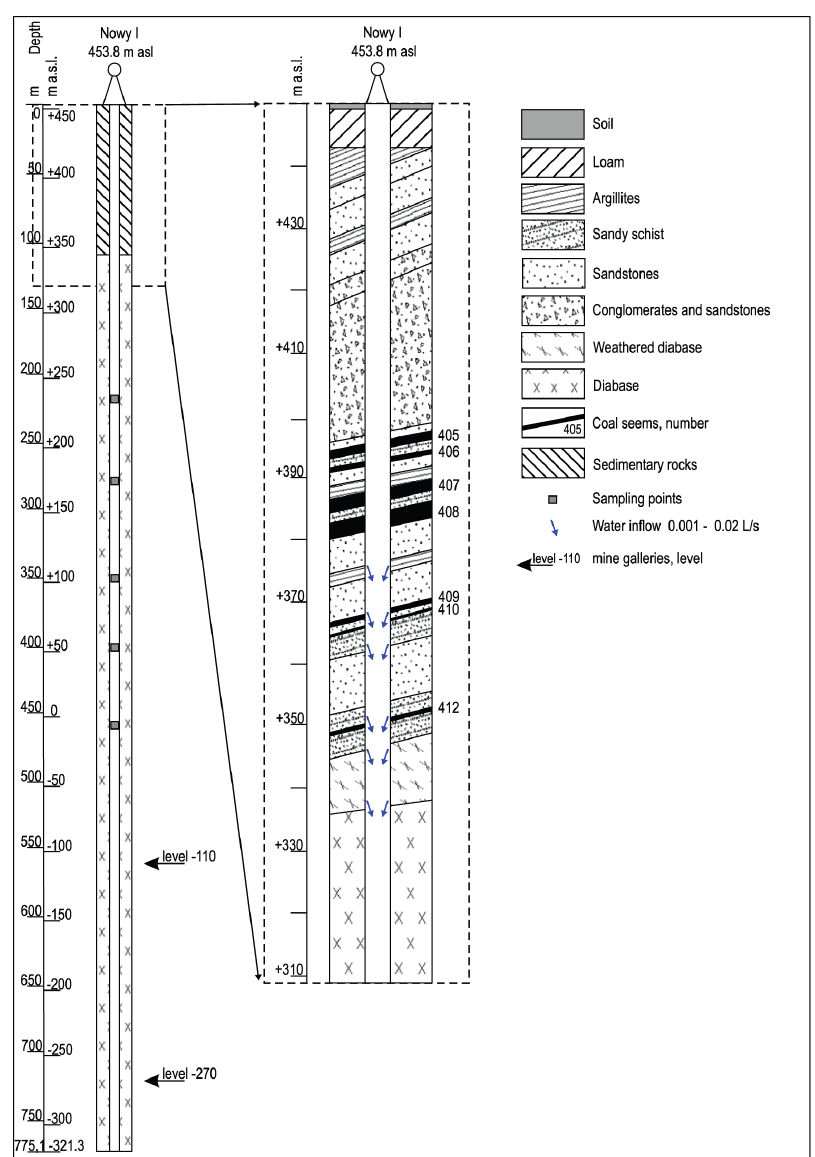
Figure 3. Construction scheme, geological profile and sampling points of the “Nowy I” shaft (authors’ concept based on unpublished archival